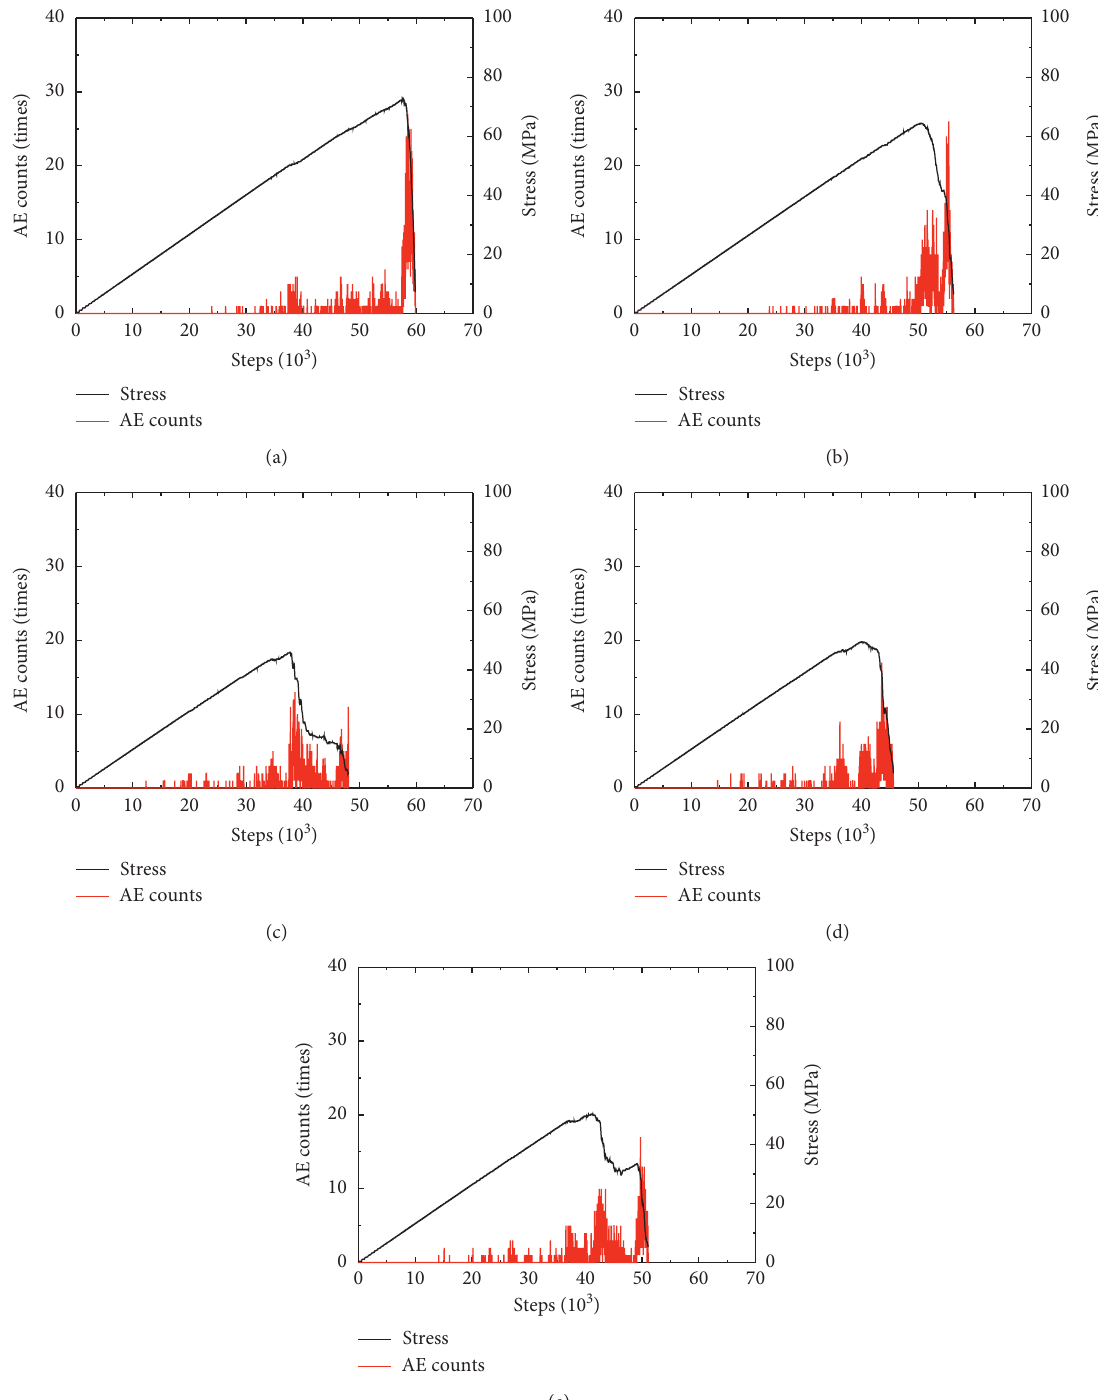
Figure 19: Stress-time-AE counts of samples with different boreholes arrangement form. The arrangement forms of (a), (b), (c), (d), and (e) are vertical layout, horizontal layout, inclined layout, up three-flower layout, and down three-flower layout,